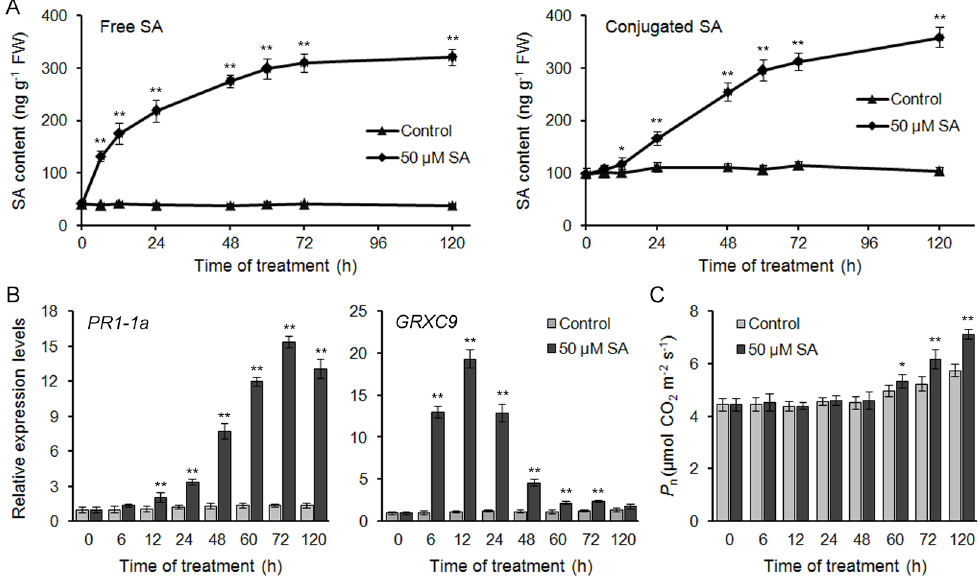
Fig 1. Time courses of endogenous SA accumulation, PR1-1a and GRXC9 expression, and net photosynthetic rate ( P n ) in the leaves of cucumber seedlings upon SA treatment. (A) The contents of endogenous SA, in both free and conjugated forms. (B, C) The relative expression levels of PR1-1a and GRXC9 (B) and P n (C) at different times after SA treatment. The seedlings that were treated without SA were used as controls. Data represent the means of three replicates ± SD. * P < 0.05 and ** P < 0.01 compared to the corresponding value from the